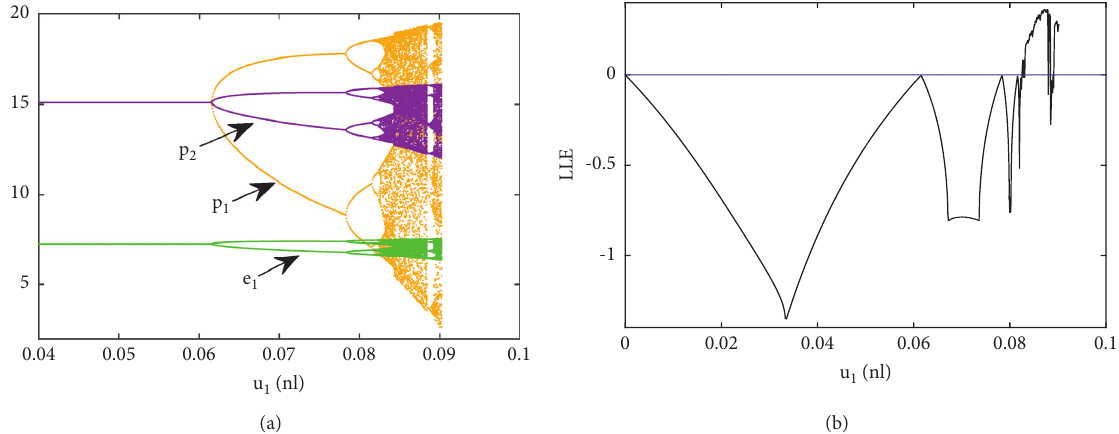
Figure 4: (a) Bifurcation diagram and (b) LLE of the system (10) with varying u